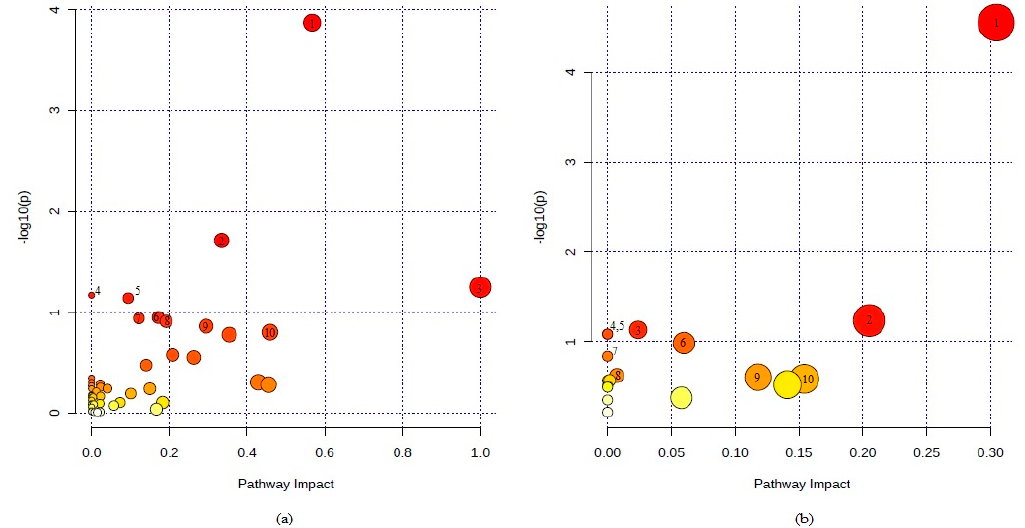
Figure 1. Metabolic pathway analysis performed for significant metabolites reported in human serum ( a ) and aqueous humor (AH) ( b ) samples. Metabolic pathway analysis was carried out with MetaboAnalyst 4.0 software. Ten most significant pathways identified for the serum samples: 1. sphingolipid metabolism, 2. citrate cycle (TCA cycle), 3. linoleic acid metabolism, 4. biosynthesis